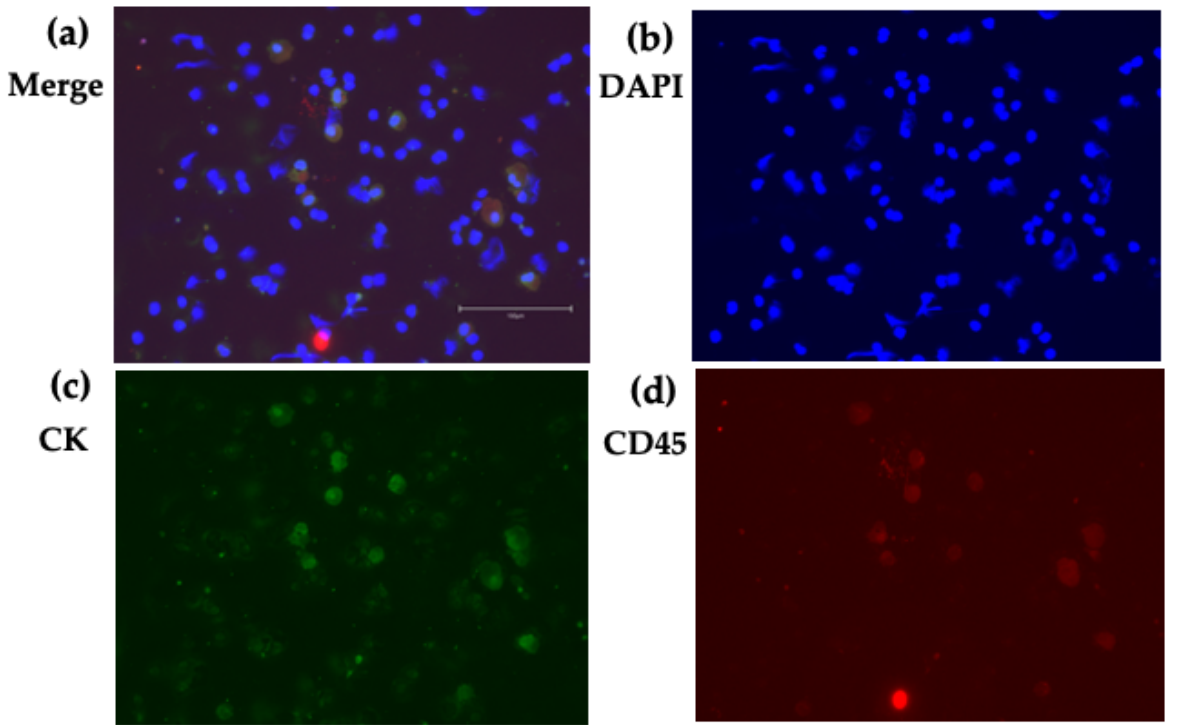
Figure 3. CK/CD45 double positive cells. Cells obtained from the short-term (35 days) CTC culture. Cytospin image: ( a ) Merge, ( b ) DAPI, ( c ) CK, and ( d ) CD45. The scale bar shows 150 μ m. Some cells express both CK and CD45.